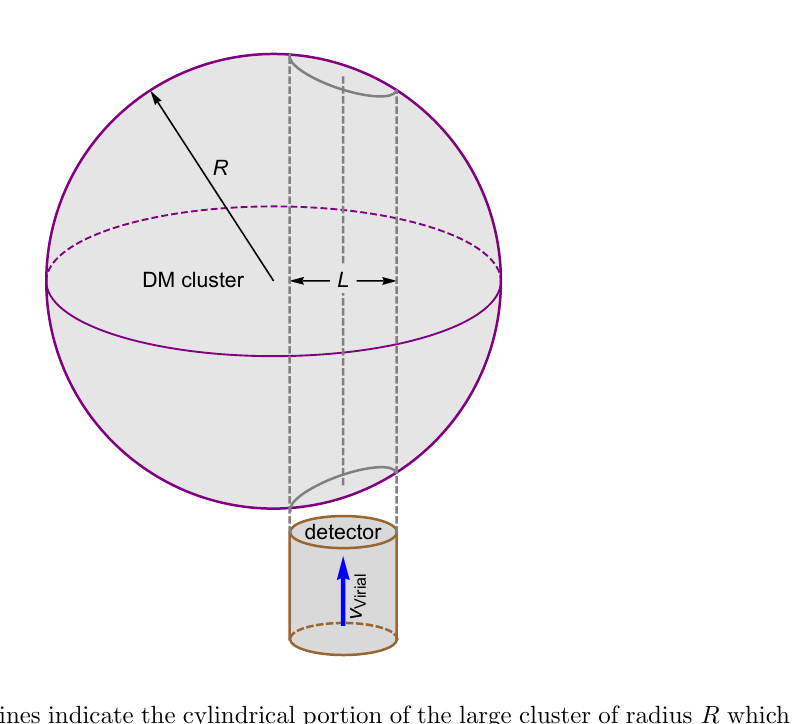
Figure 3 . The dashed lines indicate the cylindrical portion of the large cluster of radius R which a detector of size L < R traverses. We refer to this as the cylindrical overlap region of volume (cid:25)L 2 R